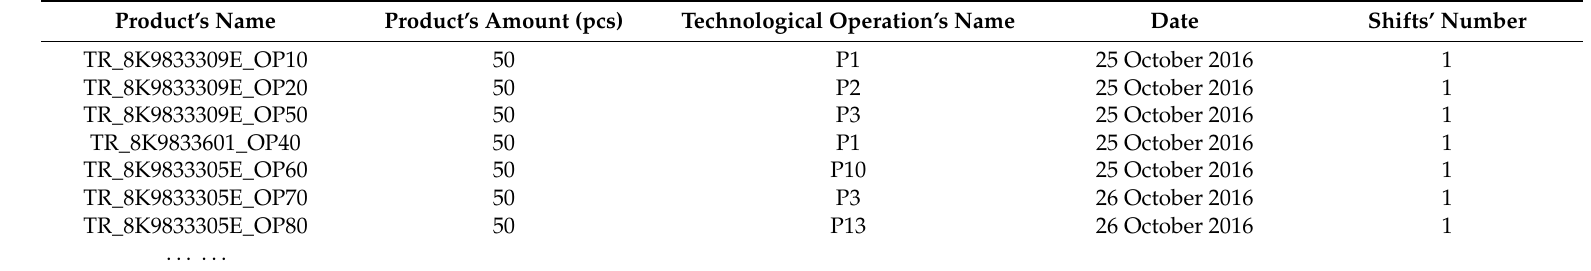
Table 9. Production plan data